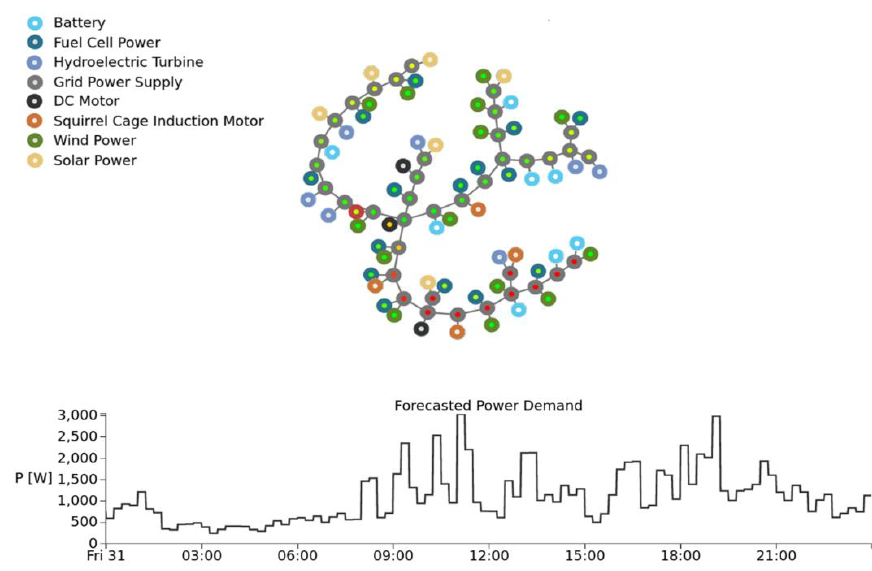
Figure 27. Mosaik co-simulation: Forecasted Power Demand.